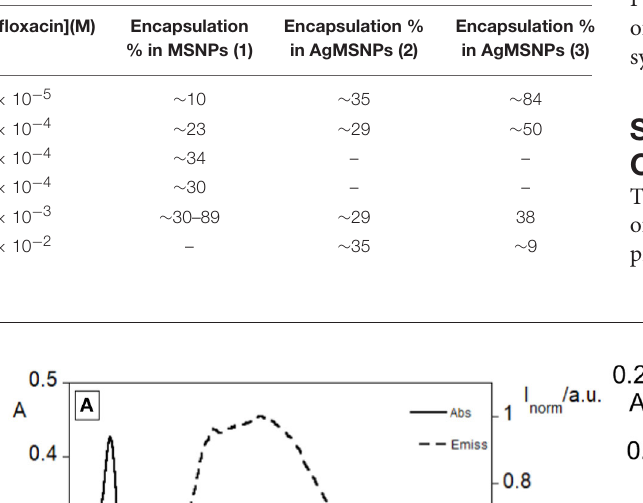
Frontiers in Chemistry |